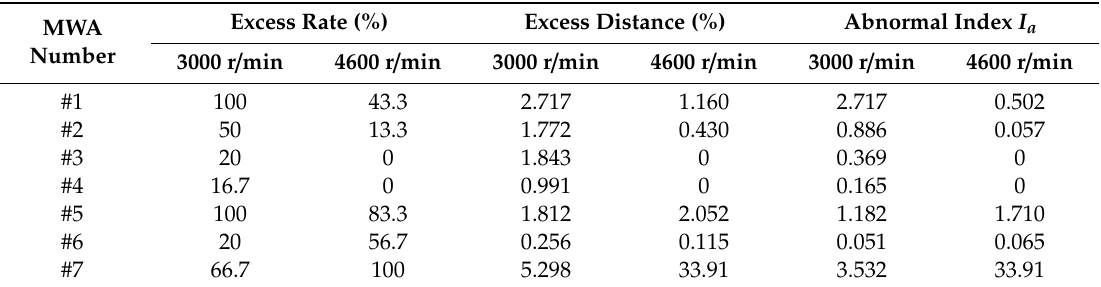
Figure 18. Flywheel #7 test noise sample point and security domain: ( a ) 3000 r / min; ( b ) 4600 r / min. Table 2. Excess rates of seven tested MWAs with the same structural parameters at a rotating speed of 3000 r /